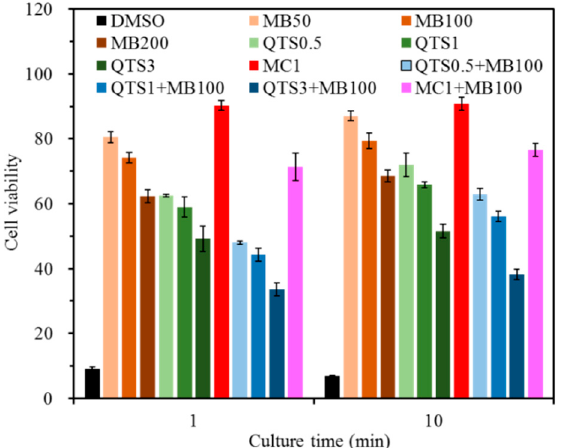
Figure 1. Cytotoxicity of L929 cells cultured with different test agents for 1 and 10 min. The cell viability was normalized to the negative control (culture medium) in terms of absorbance (n = 3).